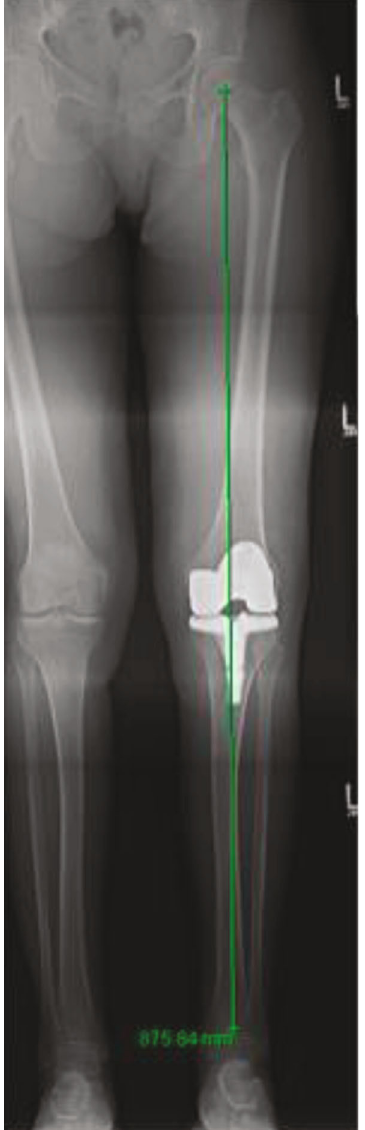
Figure 23: Postoperative full-leg standing radiograph of the left leg for Case 5 showing the corrected neutral mechanical alignment following